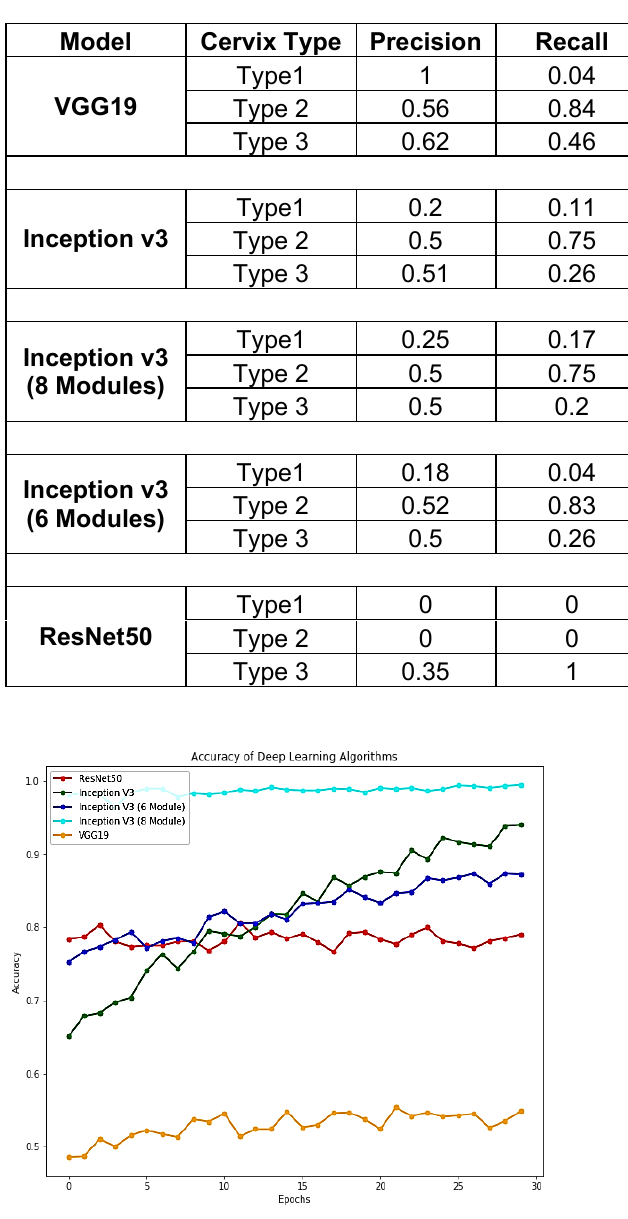
Figure 5. Accuracy of Models on Training Set